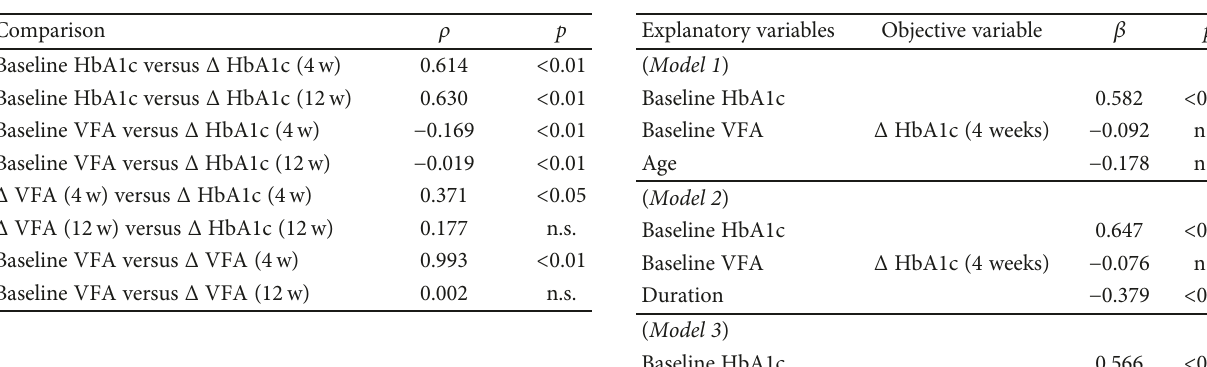
Table 3: Various parameters associated with the e ffi cacy of tofogli fl ozin in univariate analyses.